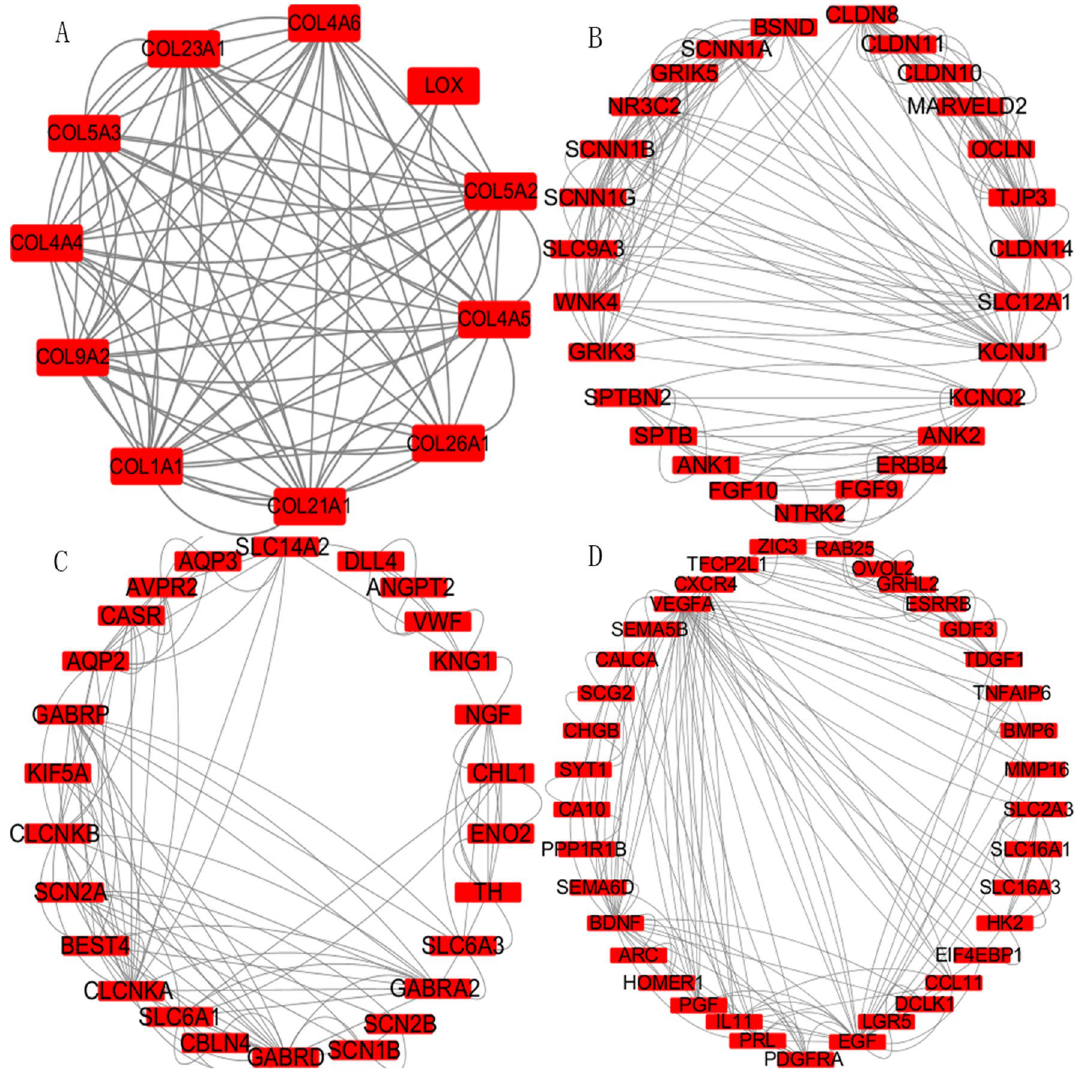
Figure 3. The PPI network is visualized in cytoscape and the MCODE algorithm will modularize the network. The figure shows the four modules filtered by a score greater than 4.5. ( A ) Module 1 11 nodes 88 edges ( B ) Module 2 27 nodes 168 edges ( C ) Module 3 26 nodes 116 edges ( D ) Module 4 37 nodes 164